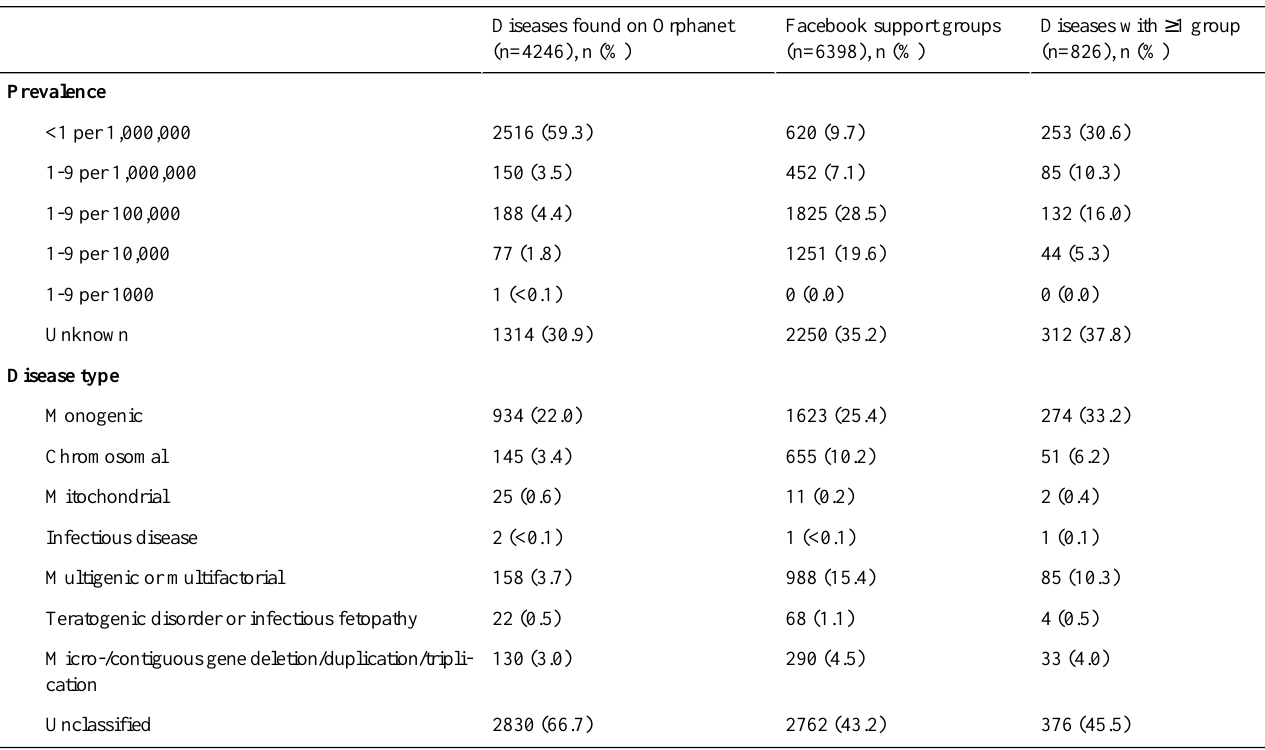
Table 1. Diseases and Facebook support groups by prevalence and type of disease.